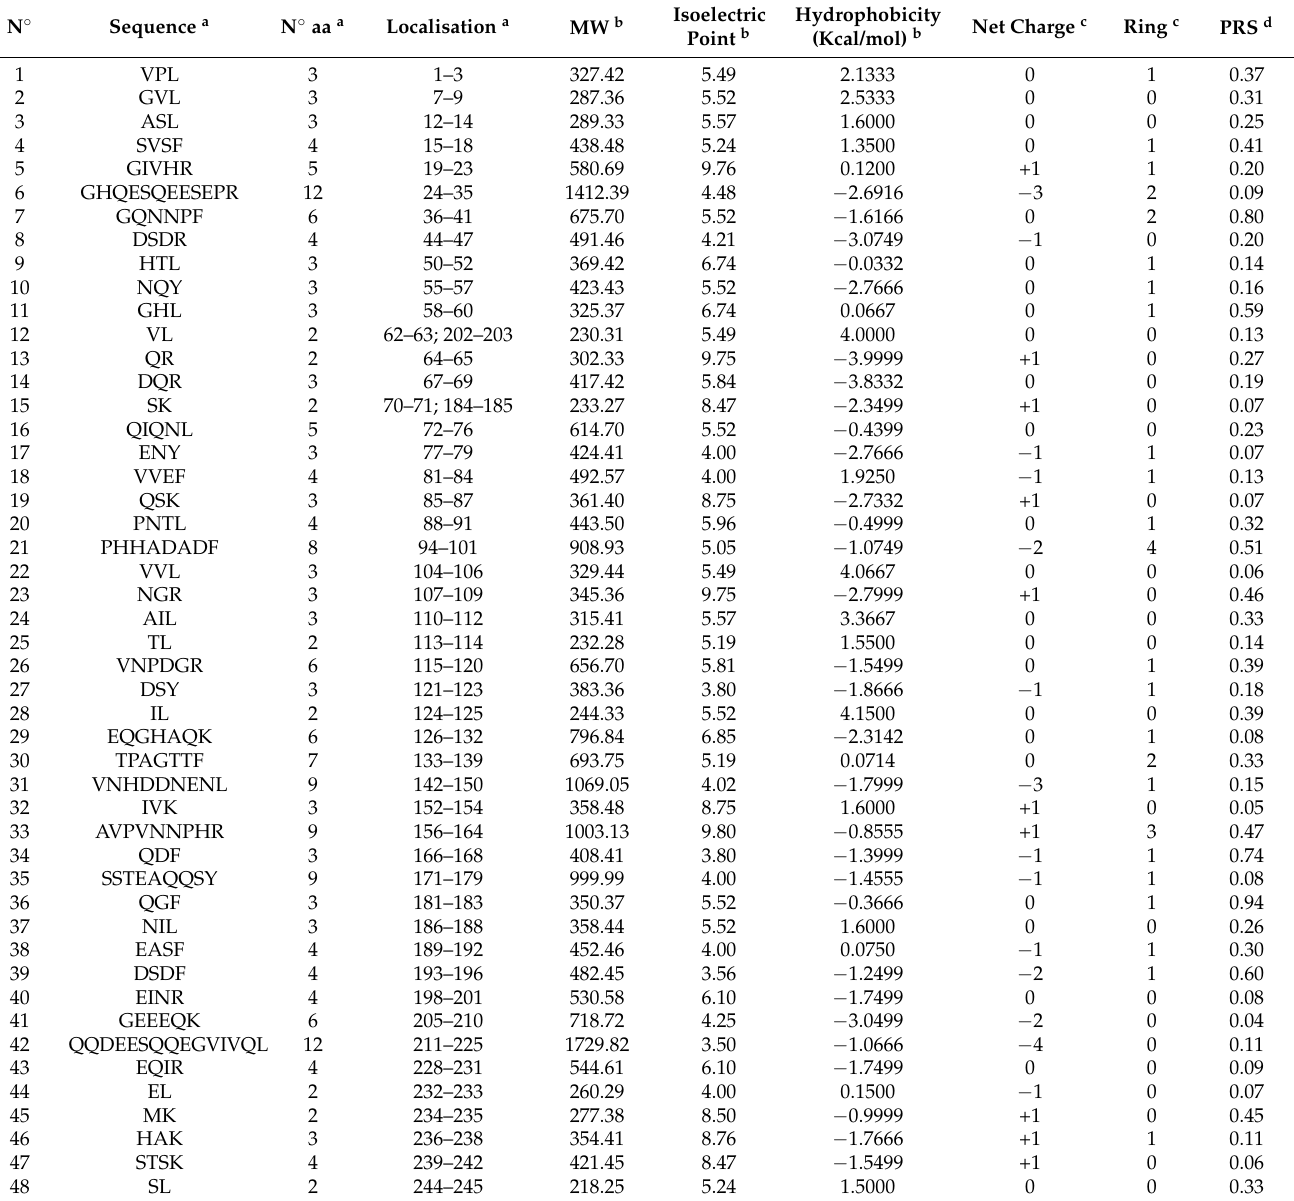
Table 1. Molecular characteristics of peptides derived from cowpea β -vignin via sequential hydrolysis in silico. N